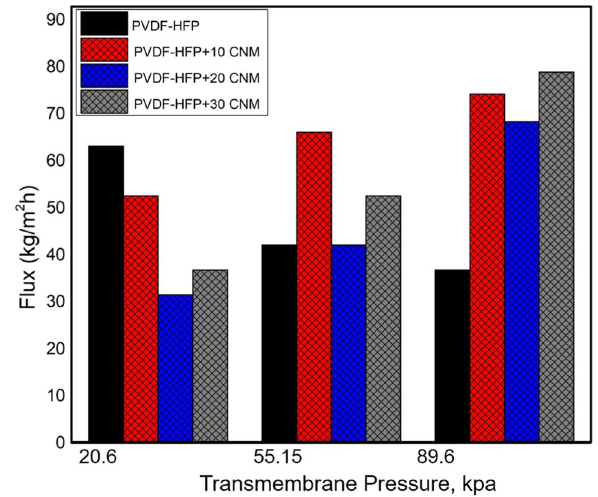
Fig. 5 Effect of CNMs/PAC loading on the porosity of the composite membranes